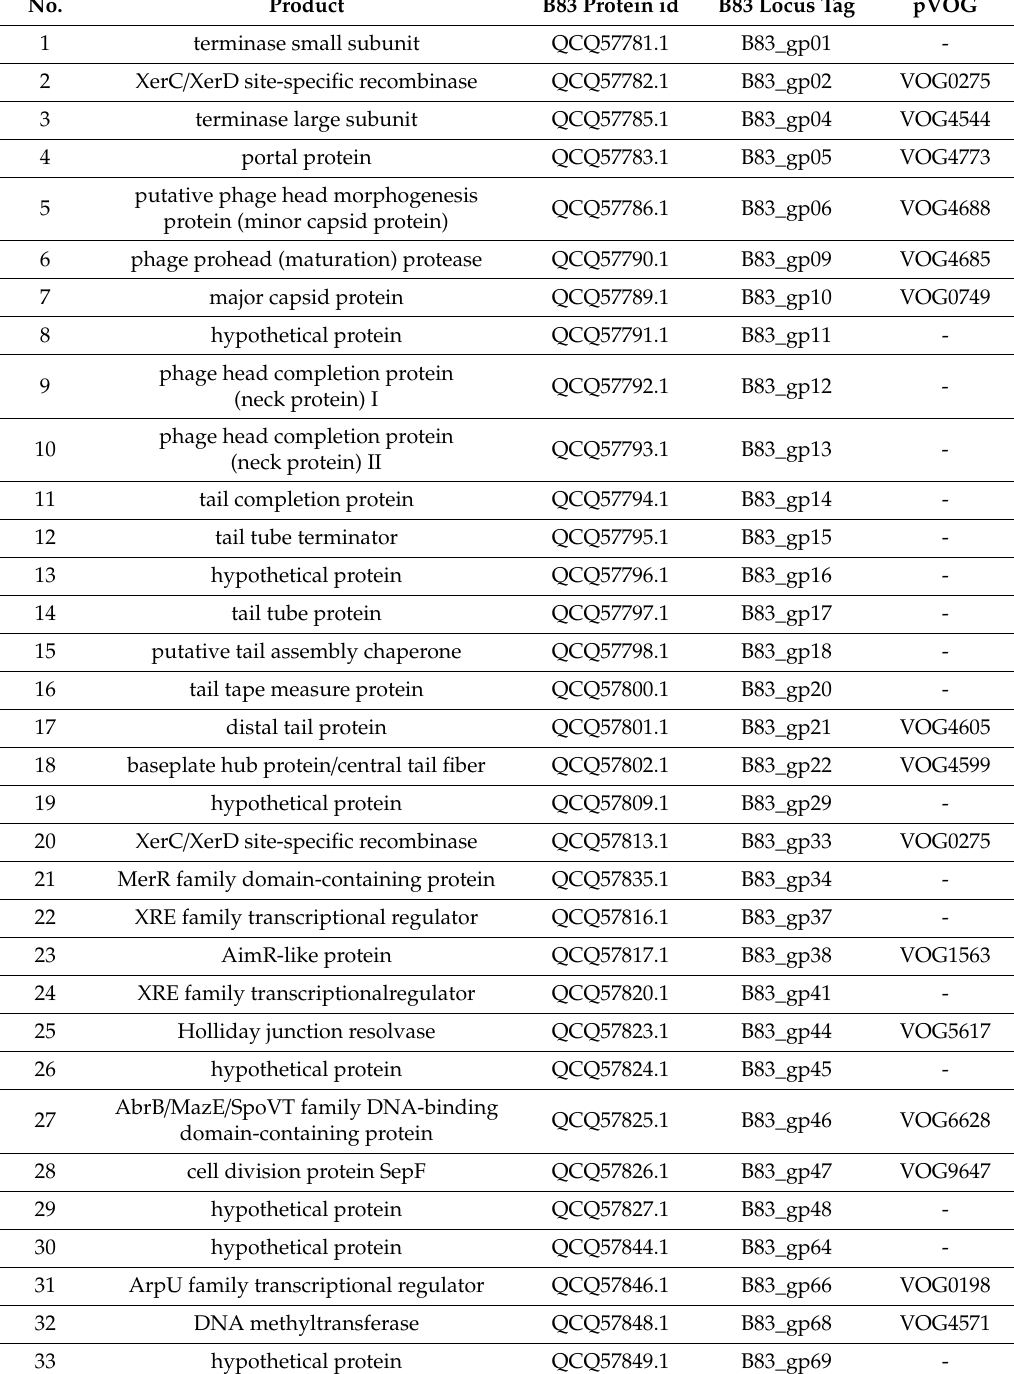
Table 3. Thirty-three conserved genes among the four genomes (B83, plasmid unnamed 2, pBTHD521-2, BMBtp14) determined by CoreGenes3.5, and their annotation (as was assigned for B83). Prokaryotic Virus Orthologous Groups (pVOGs) determined from translated open reading frames (ORFs) are